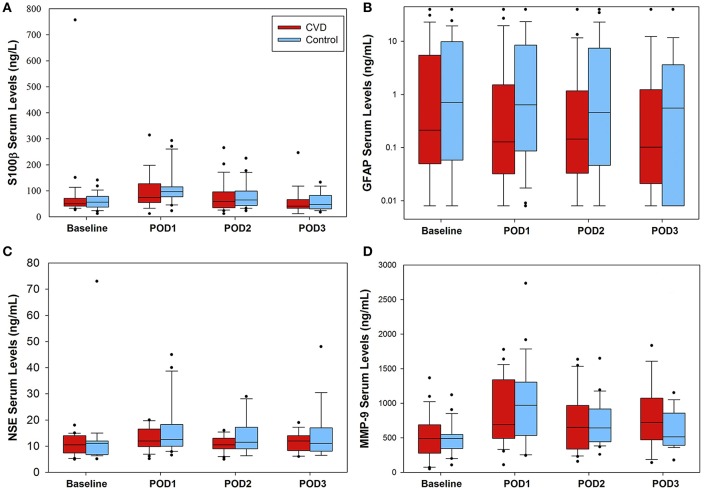
Serum biomarker concentrations in the perioperative setting. No significant differences between groups were found for any of the biomarkers tested. (A) S-100β data presented. For the cerebrovascular disease (CVD) group, number of samples were as follows (baseline through POD3): 25, 25, 24, 19, respectively; control group: 25, 25, 24, 19. (B) glial fibrillary acid protein (GFAP) levels varied considerably within both groups, ranging from 0.008 to 40 ng/mL. Number of CVD group daily samples: 25, 24, 24, 19; control group samples: 25, 25, 24, 18. (C) Daily neuron specific enolase (NSE) serum levels. Number of CVD group daily samples: 20, 22, 22, 15; control group: 19, 20, 18, 16. Lastly, (D) matrix metalloproteinase-9 (MMP-9) data presented. Number of CVD group daily samples: 25, 25, 24, 17. Control group daily samples: 23, 24, 22, 17. POD = postoperative day.